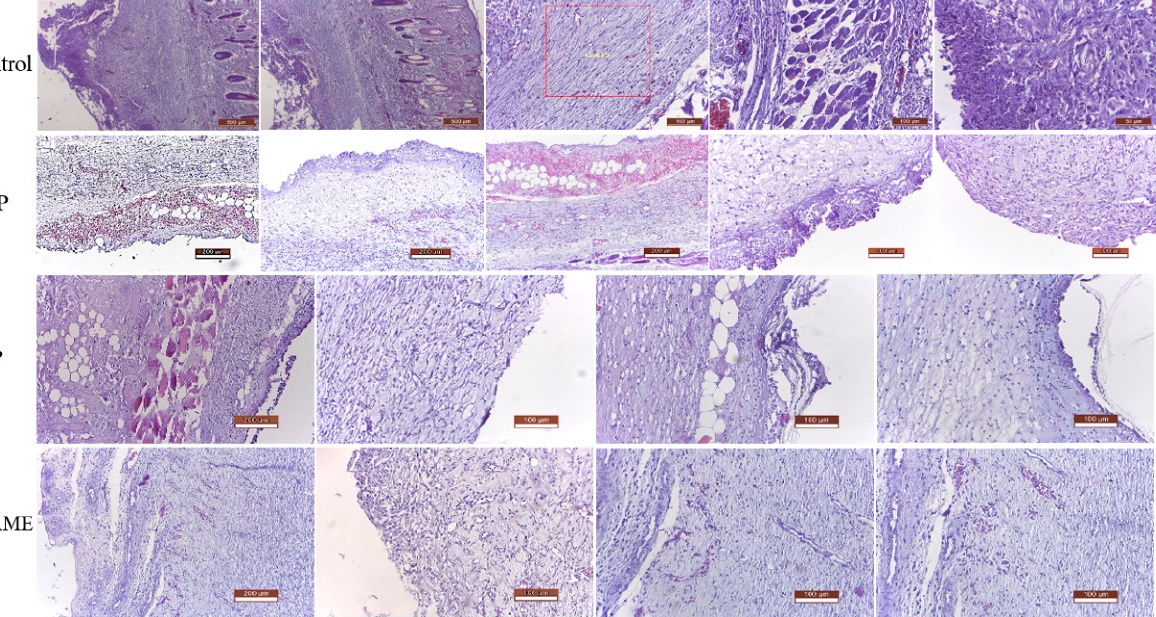
Figure 4. Histopathological details of the flaps in the condition of different treatments; ( a ) Control group (1st line—5 pictures p.); ( b ) CAP group (2nd line—5 p.), ( c ) PRP group (3rd line—4 p.); ( d ) L-NAME group (4th line—4 p.). Table 2. Scoring of the histological findings in control and treated groups at flaps’ level.